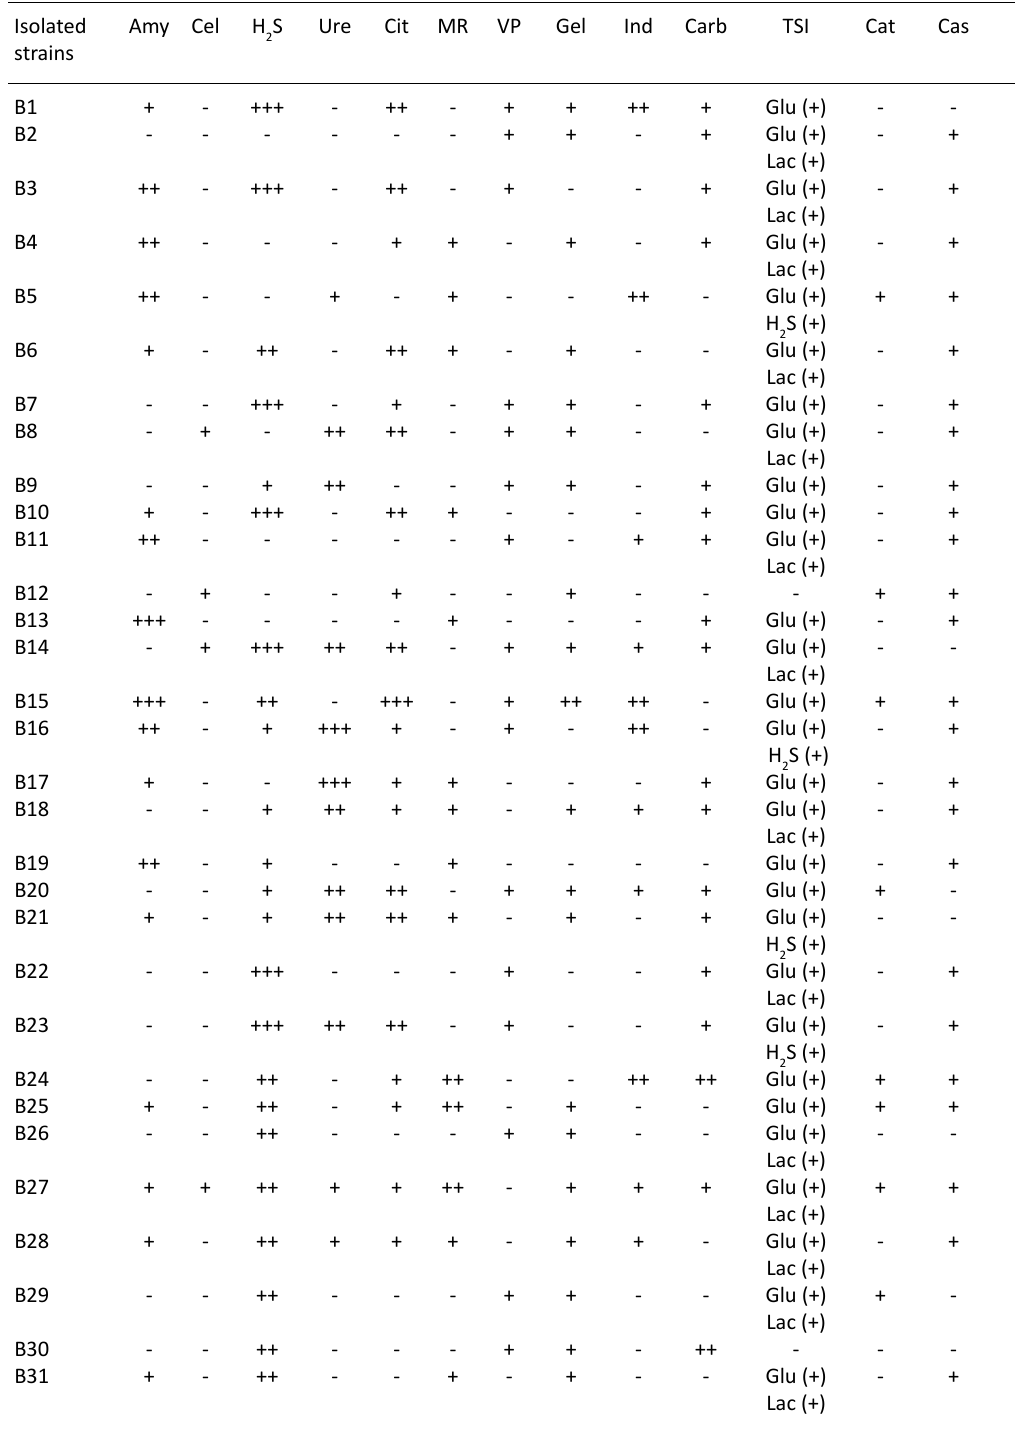
table 3. Biochemical characterization of the isolated strains Isolated